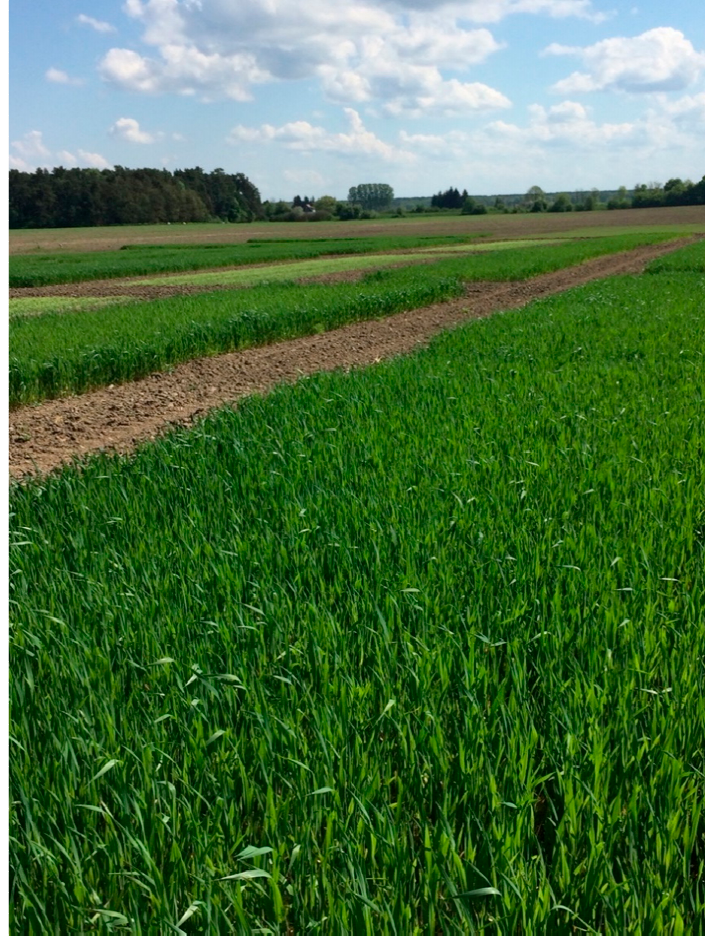
Figure 1. General view of the experiment. Winter wheat at the shooting stage (33–35 in the BBCH (Biologische Bundesanstalt, Bundessortenamt und Chemische Industrie) scale).